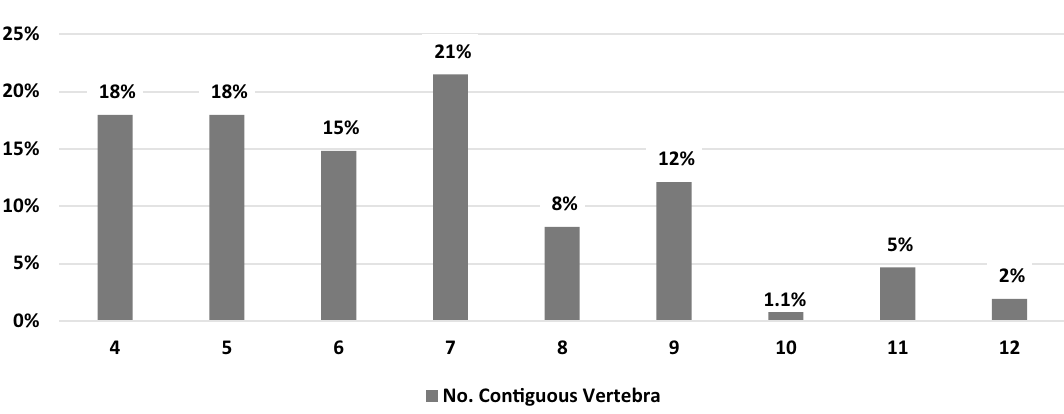
Figure 4. Number of the contiguous vertebrae of the thoracic diffuse idiopathic skeletal hyperostosis.